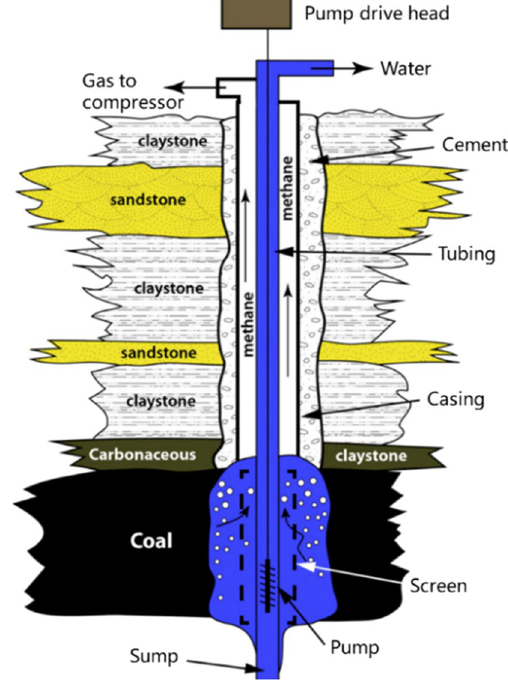
Fig. 25 Schematic of open-hole completion (Moore, 2012)